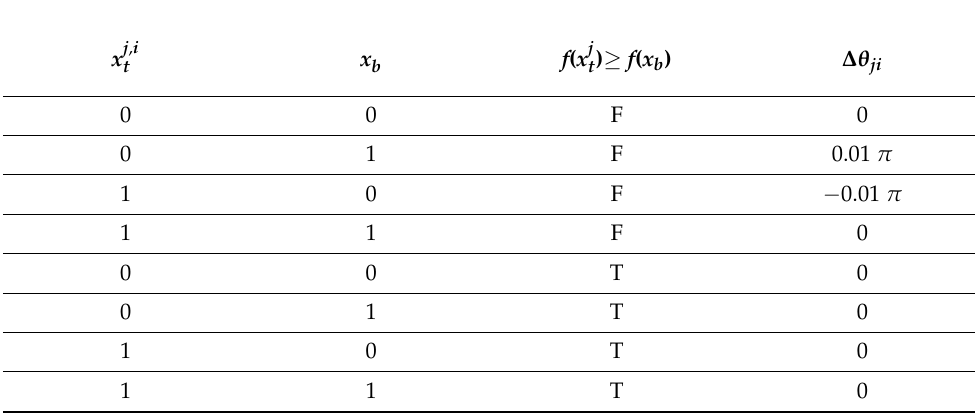
Table 1. Predefined value of ∆ θ ji